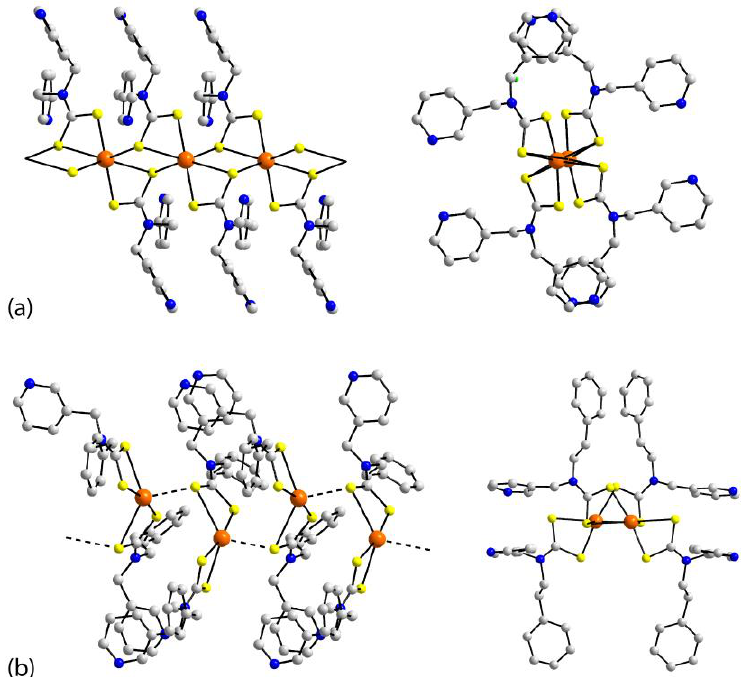
Figure 14. The zig-zag supramolecular chain mediated by the Hg · · · S interactions in ( a ) [Hg(L 10 ) 2 ] n ( 47 ) and ( b ) [Hg(L 22 ) 2 ] n ( 48 ).